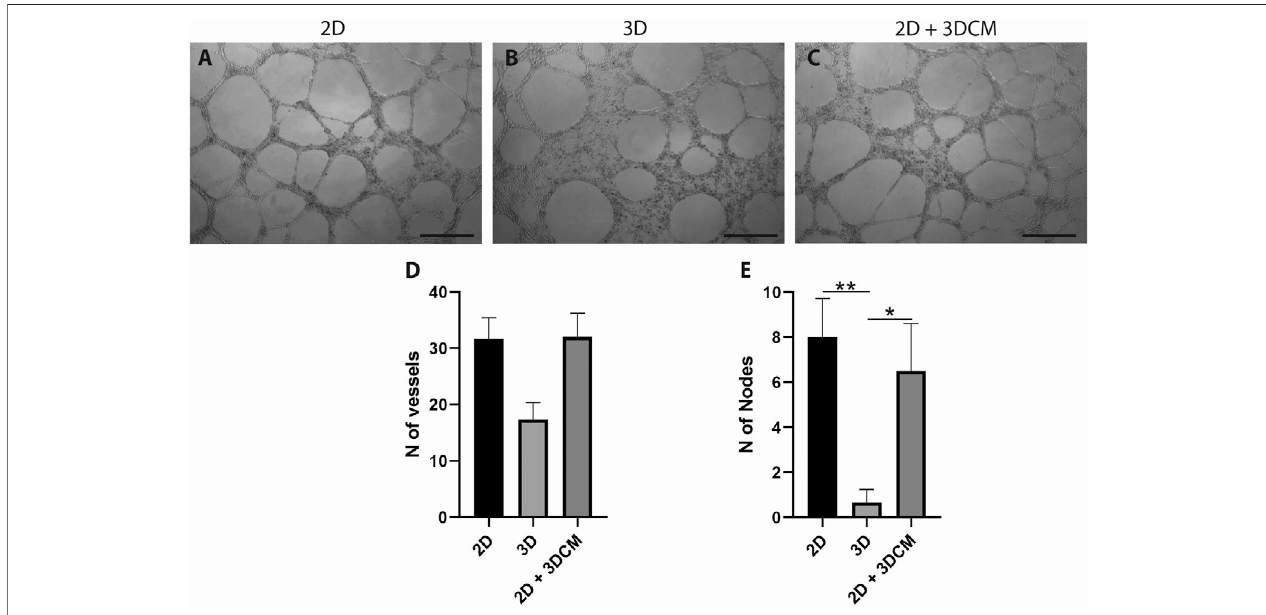
FIGURE 7 | Capillary-like tubule formation assay of expanded CD133+ cells cultured for 12 h on a Matrigel layer. Representative image of tubule-like formation for each group (A) control (B) 3D cells and (C) 3D secretome. Scale bar (cid:1) 500 µm. Analysis of the number of (D) vessels and (E) nodes formed after 12 h. Graphs are represented by the mean ± SD. One-way ANOVA: * p ≤ 0.05; ** p ≤ 0.01 (2D n (cid:1) 3; 2D + 3DCM n (cid:1) 2; 3D n (cid:1)